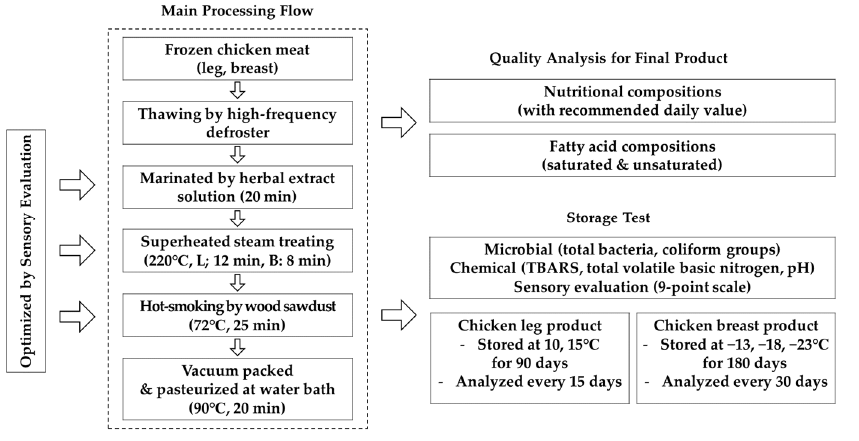
Figure 1. Schematic representation of the development of chicken leg and breast products: L, leg and B, breast.